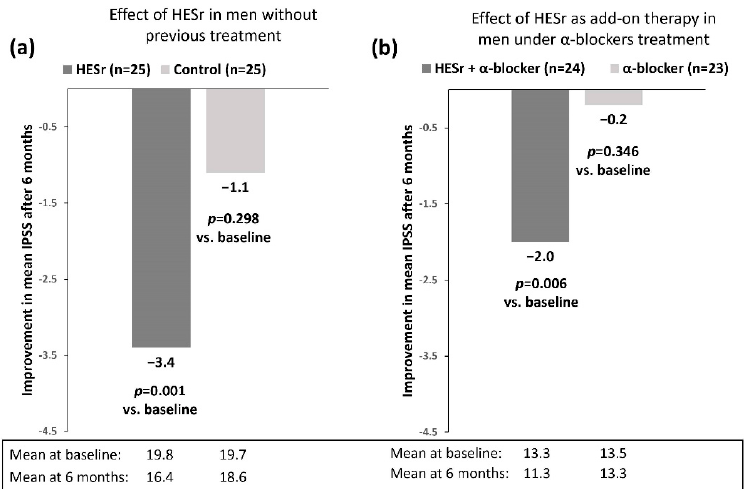
Figure 4. Improvement in mean IPSS after 6 months of HESr therapy (320 mg/day) in men without previous treatment ( a ) and men under treatment with α -blockers ( b ) [37]